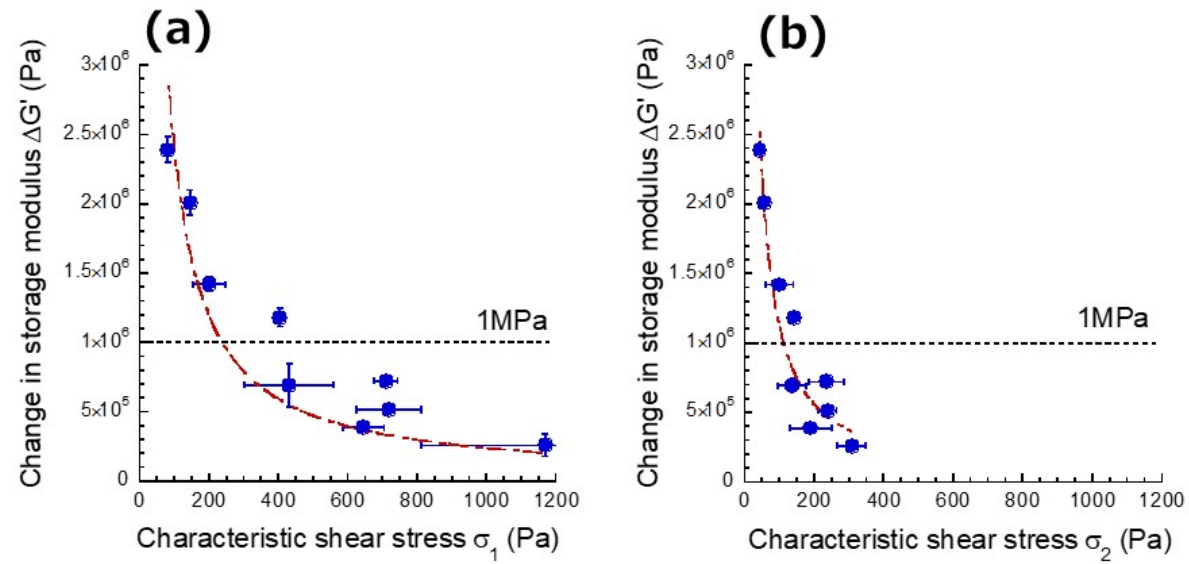
Figure 5. Relationship between change in storage modulus and characteristic stress ( a ) σ 1 or ( b ) σ 2 for magnetic hydrogels with various carrageenan concentrations (CI: 70